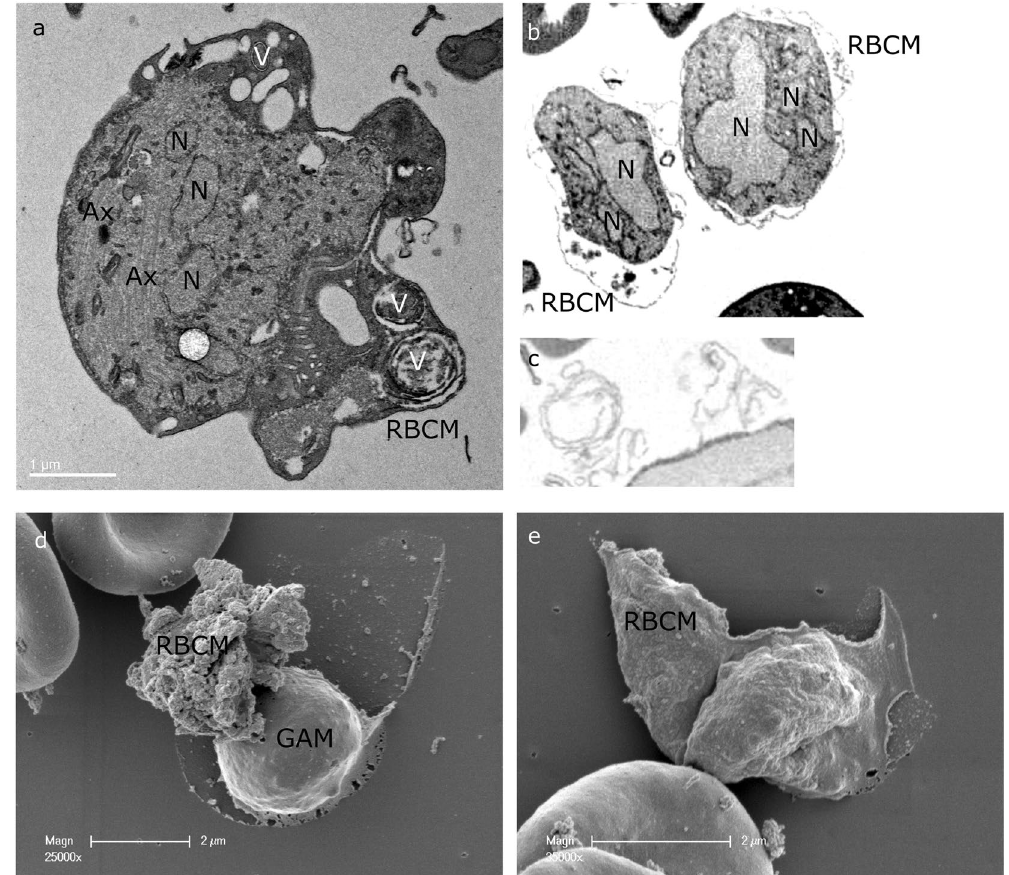
Figure 8. Electron microscopy analysis. ( a ) An activated male gametocyte. Inside the intact RBCM three vesicles are visible (V) probably derived from the PVM. No PVM surrounds the gametocyte. ( b ) Two activated gametocytes where the red blood cell cytoplasm has been completely digested. The RBCM is still intact. ( c ) Membrane spirals and whorls detected free in samples of activated gametocytes. ( d,e ) Scanning EM of activated gametocytes. ( d ) A cell is surrounded by a thin membrane collapsed on the grid. A convoluted empty membrane is located next to it. The rough surface suggests that the inner leaflet faces outwards. ( e ) An intact membrane sheet collapsed on a cell suggesting that the membrane was opened at one point and the opening then extended. The membrane is smooth contrasting to d. Ax, axoneme; N, nucleus; RBCM, red blood cell membrane; GAM,